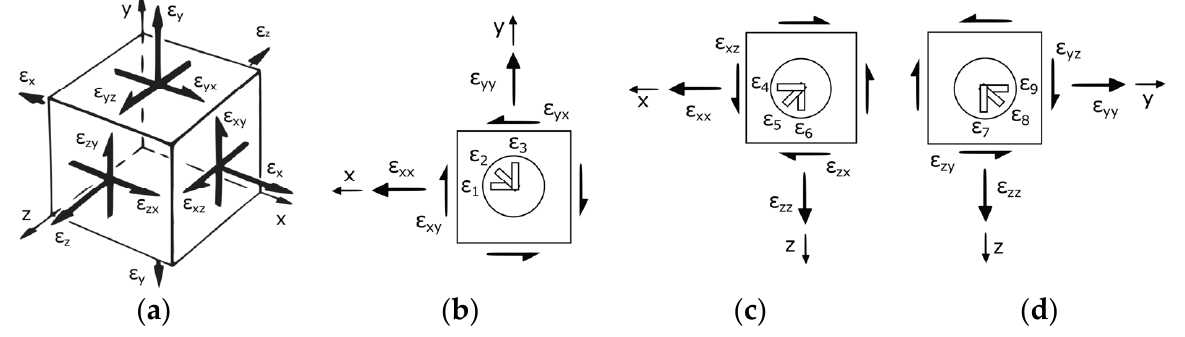
Figure 6. ( a ) Triaxial strain state; ( b ) strain gauge rosette in plane x-y; ( c ) strain gauge rosette in plane x-z; and ( d ) strain gauge rosette in plane y-z. x-z; and ( d ) strain gauge rosette in plane